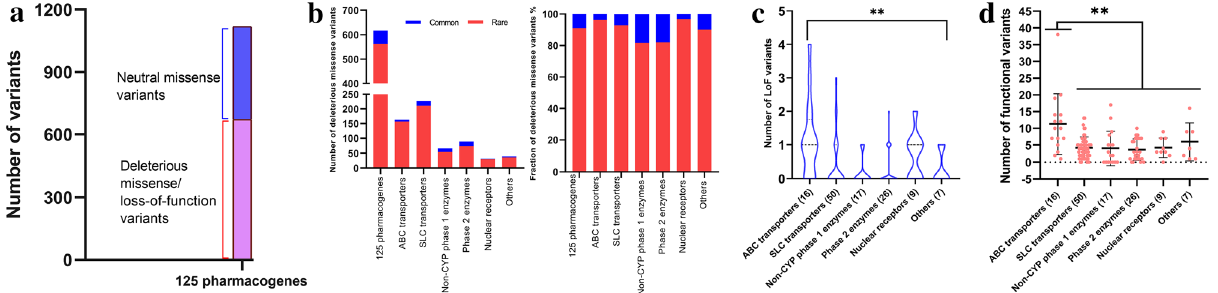
Figure 3. Rare variants were the majority of putatively functional pharmacogenes variants. ( a ) Number of neutral missense variants were 446 while deleterious missense and loss-of-function variants were 671 for the studied 125 pharmacogenes. ( b ) Number and fraction of deleterious missense variants with different variant allele frequencies in diverse pharmacogenes families. ( c ) Number of loss-of-function variants in different pharmacogenes families. ( d ) Number of functional variants (deleterious missense plus loss-of-function variants) in different pharmacogenes